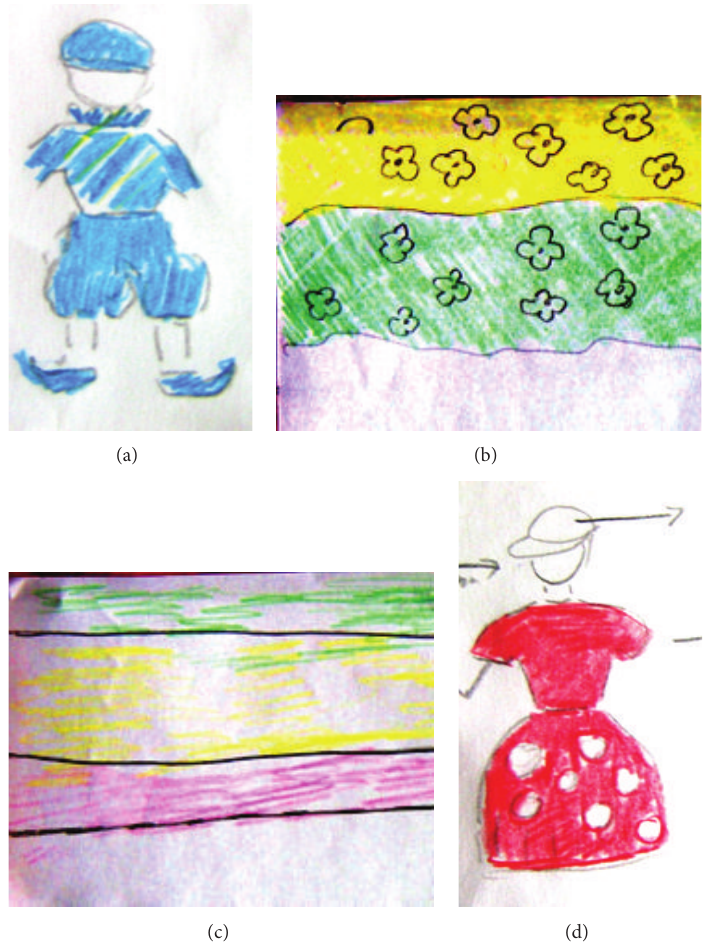
Figure 3: Drawings made by the patient (case 2) of visual illusions ((a) a real boy in illusioned blue dress) and simple ((b)-(c)) and complex ((d) unreal girl coming from a dream) visual